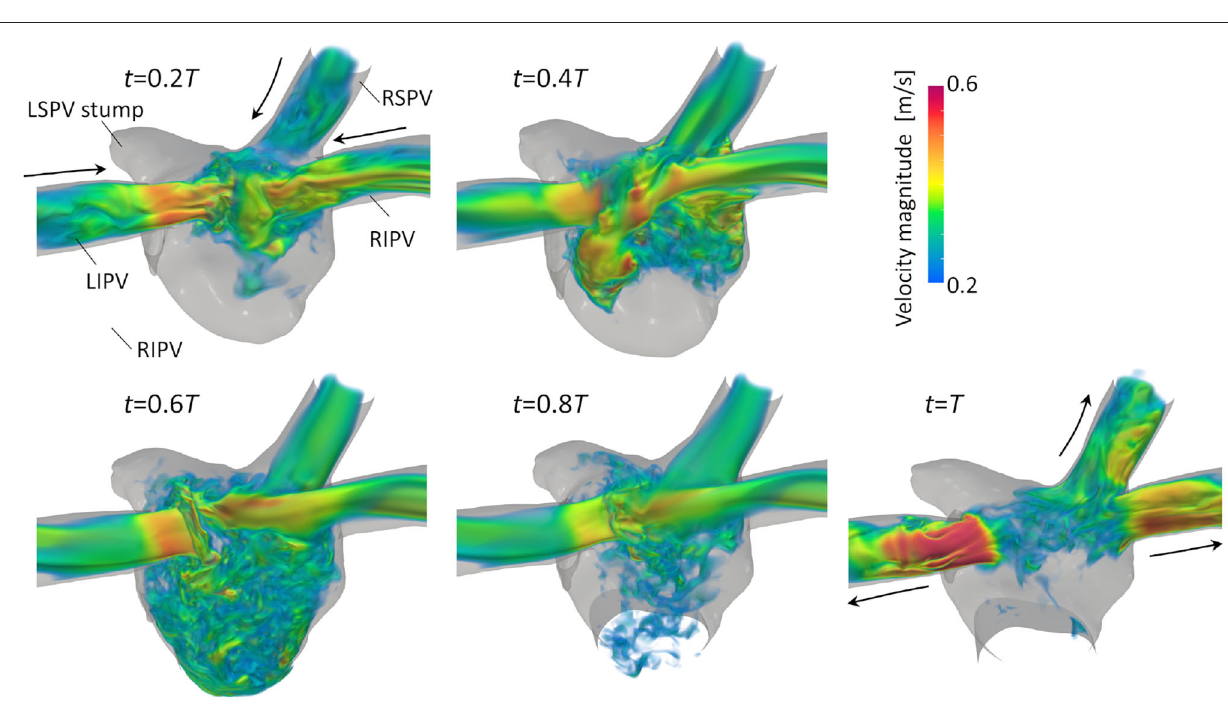
Frontiers in Physiology |